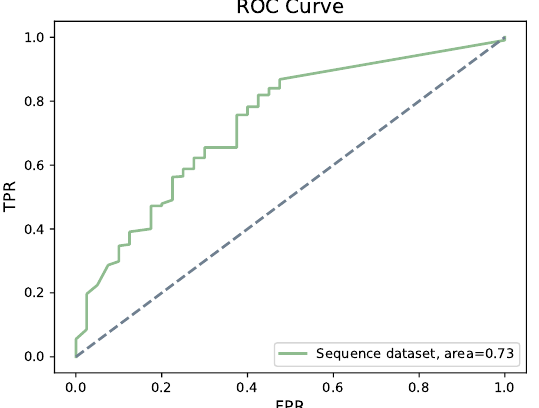
Figure 9. ROC of Bi-LSTM. Bi-LSTM shows an accuracy of 93% on sequence dataset, with an area under the curve of